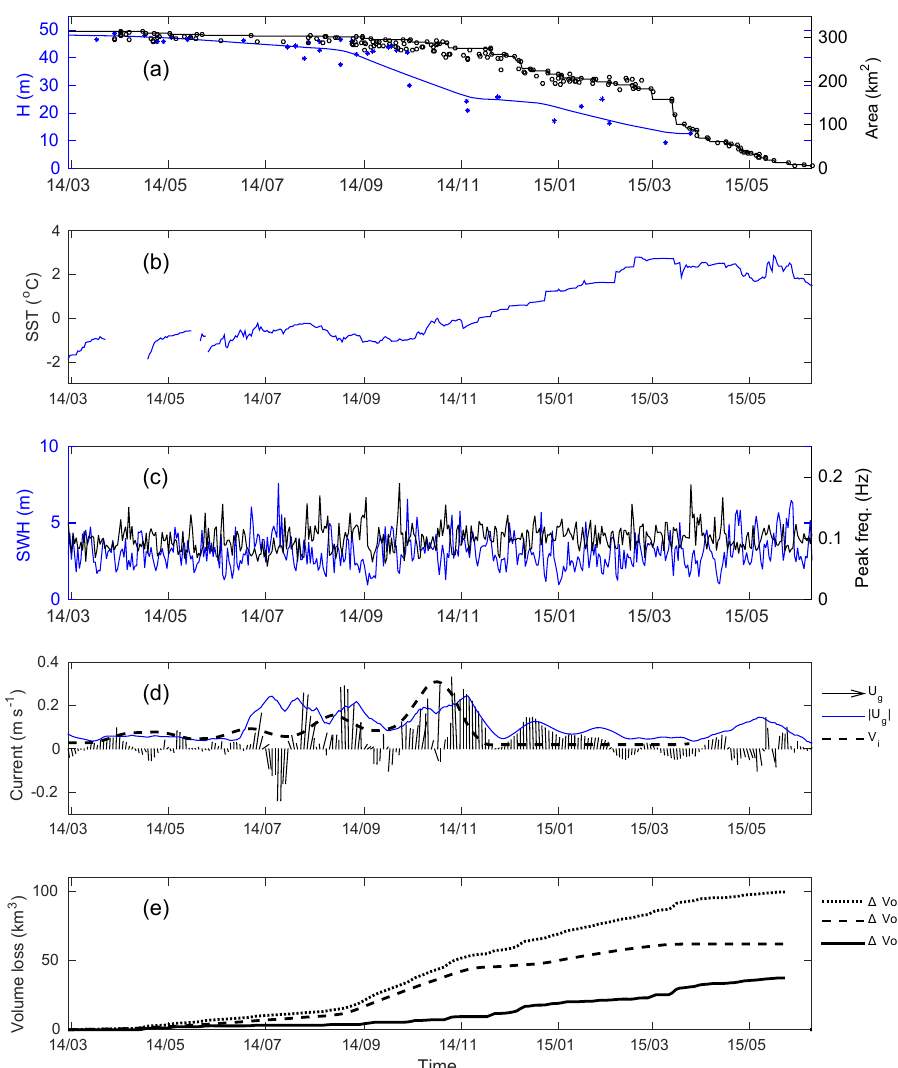
Figure 4. (a) B17a area (in km 2 ) and freeboard (in m). The black and blue lines represent the interpolated daily area and freeboard and the black circles and blue crosses the MODIS area and altimeter freeboard estimates. (b) ODYSSEA sea surface temperature (in ◦ C). (c) Significant wave height in m (blue line) and peak frequency in Hz (green line). (d) AVISO geostrophic current (black arrows), current velocity (blue line), and iceberg velocity (dashed black line). (e) Total volume loss (dotted line), volume loss by melting (dashed line), and by fragmentation (solid